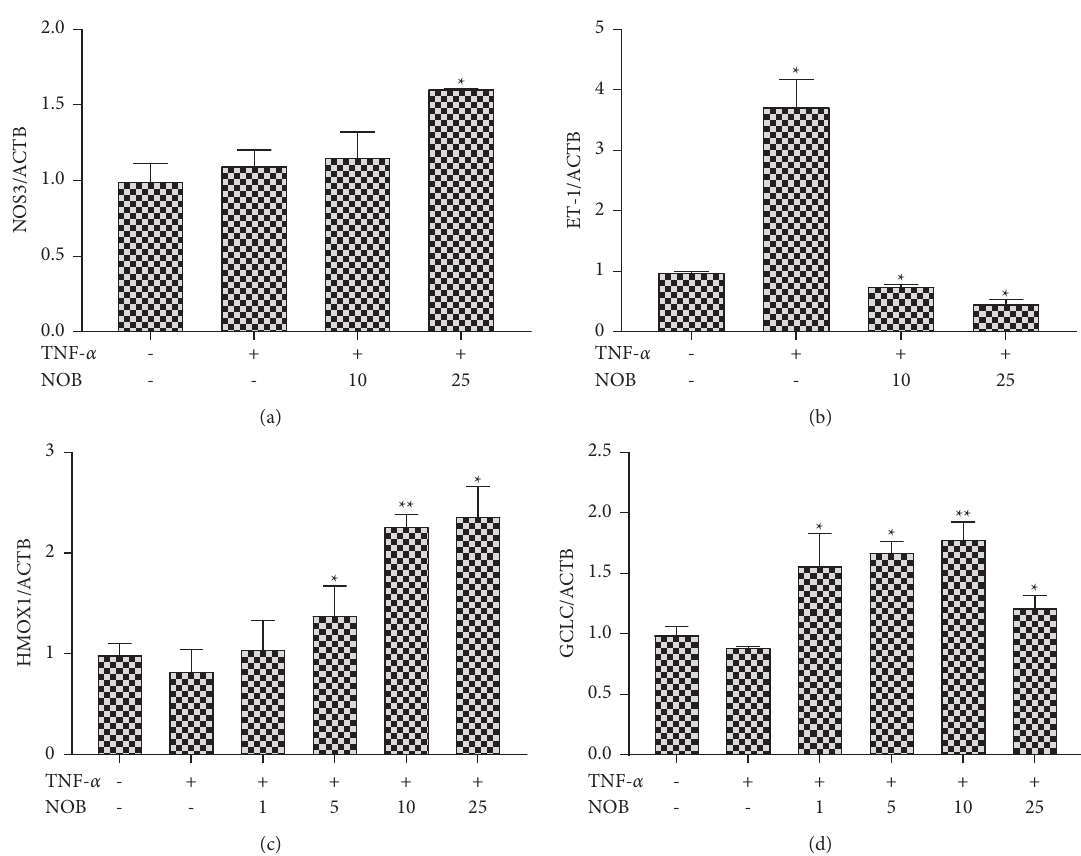
Figure 6: Effect of nobiletin (NOB) on NOS3 (a), ET-1 (b), HMOX1 (c), and GCLC (d) mRNA levels following 1h pretreatment with nobiletin followed by 18h incubation with TNF- α (10ng/mL). Data are presented as mean ± SD. ∗ and ∗∗ indicate significant differences between the treatment group and untreated control group at p < 0 . 05 and p < 0 . 01,